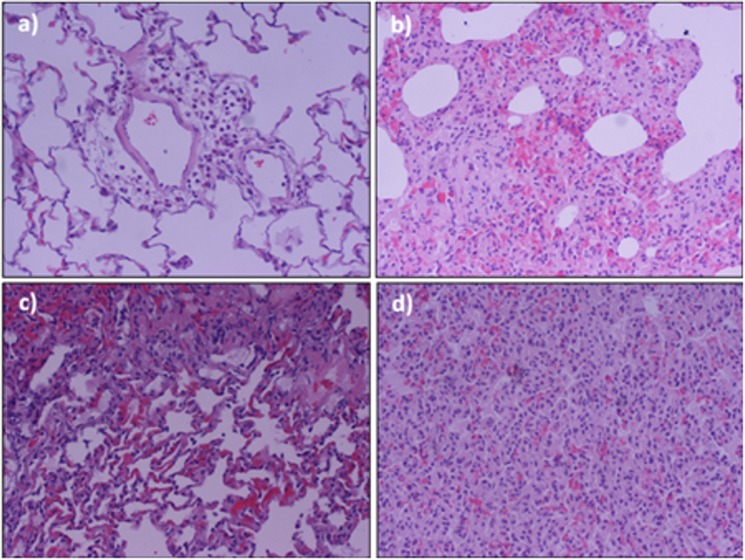
Microscopy images stained with hematoxylin-eosin showing representative lung histopathological features under different strategies of MV: a) non-ventilated non-septic controls (NA); b) Septic, anesthetized, spontaneous breathing after 4 hours (SS); c) septic after 4 hours of MV at LVT + 10 cm H2O PEEP (SLVT); and d) septic after 4 hours of MV at HVT + 2 cm H2O PEEP (SHVT).